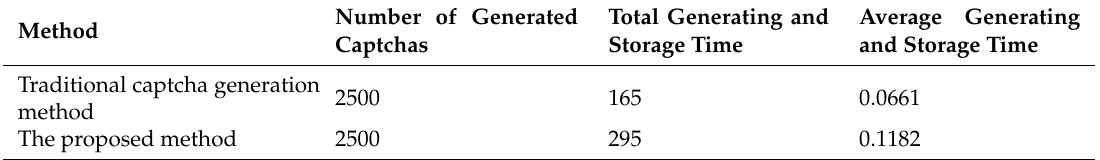
Table 4. The experimental time complexity of the proposed framework